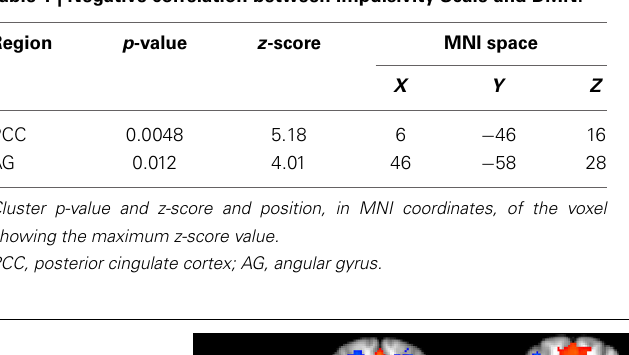
voxel (the GM + contrast), in light blue-blue color scale the anti-correlating ones (the GM − contrast). The axial slice number is displayed below each